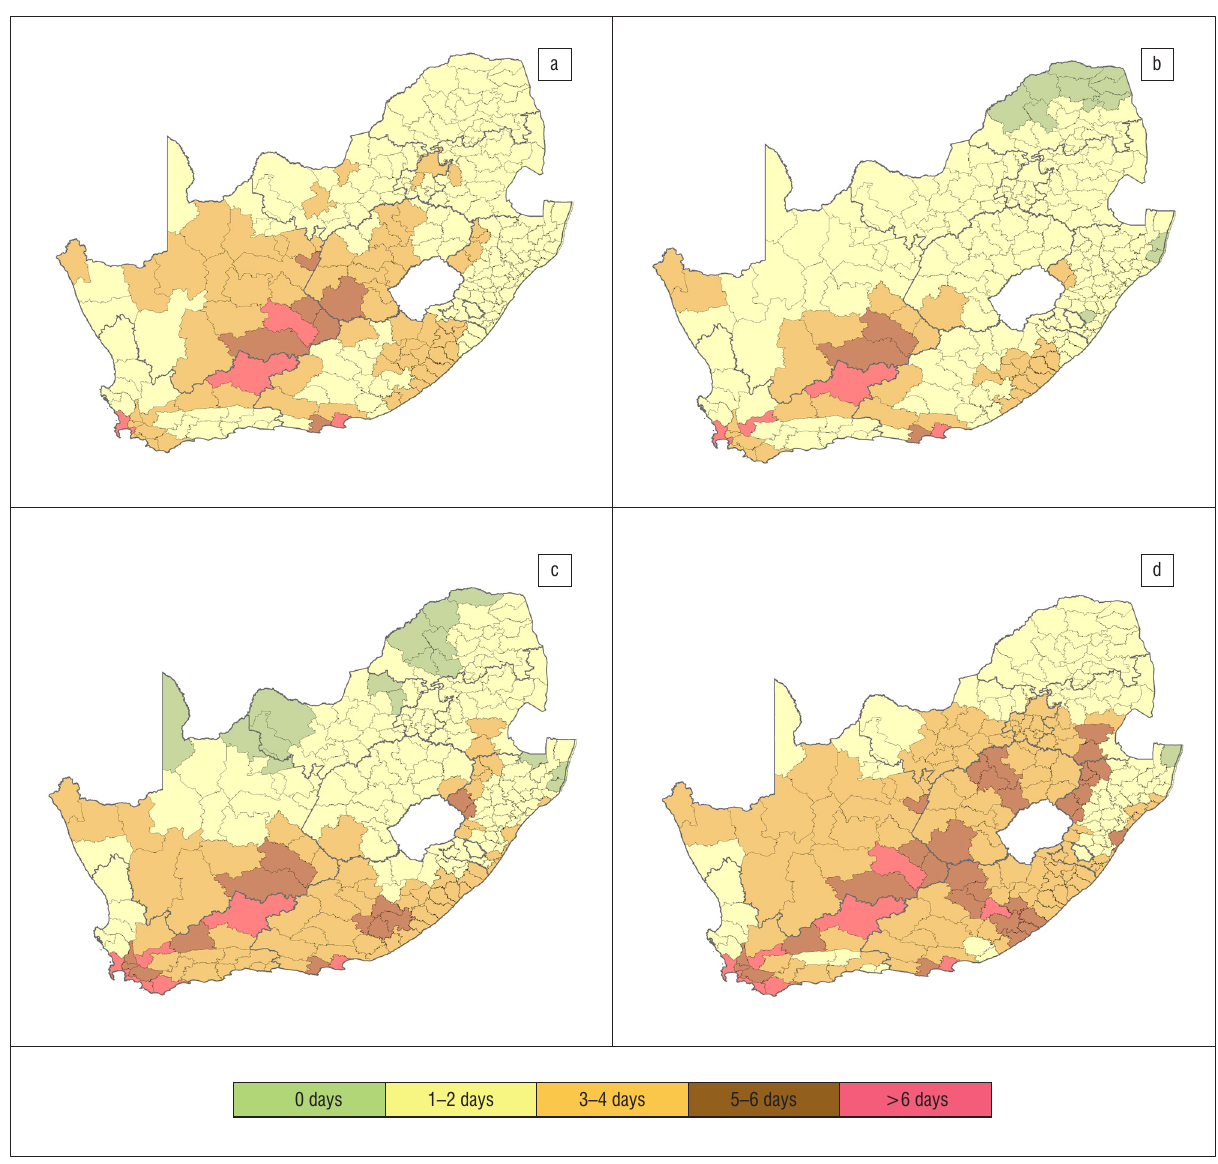
Frequency of wind hazard per season, defined as the estimated average number of days per season when the daily maximum wind gust is above 20 m/s: (a) Summer (DJF), (b) autumn (MAM), winter (JJA) and (d) spring